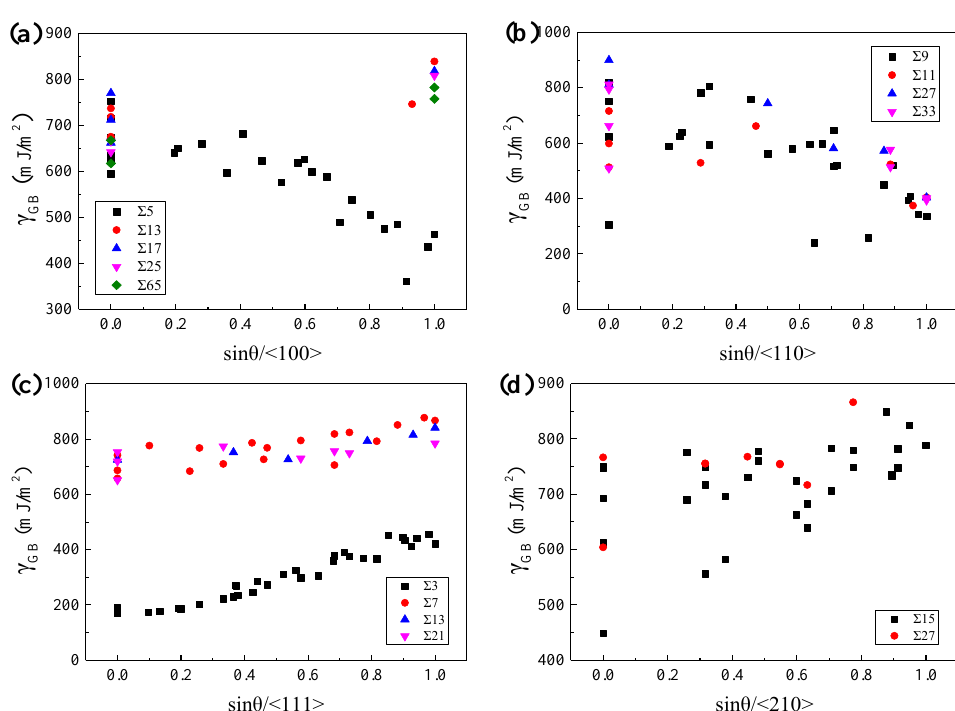
Figure 6. The GBEs of W at 2400 K as a function of sin( θ ) for GBs with the misorientation axis of ( a ) <100>, ( b ) <110>, ( c ) <111>, and ( d ) <210>, respectively.